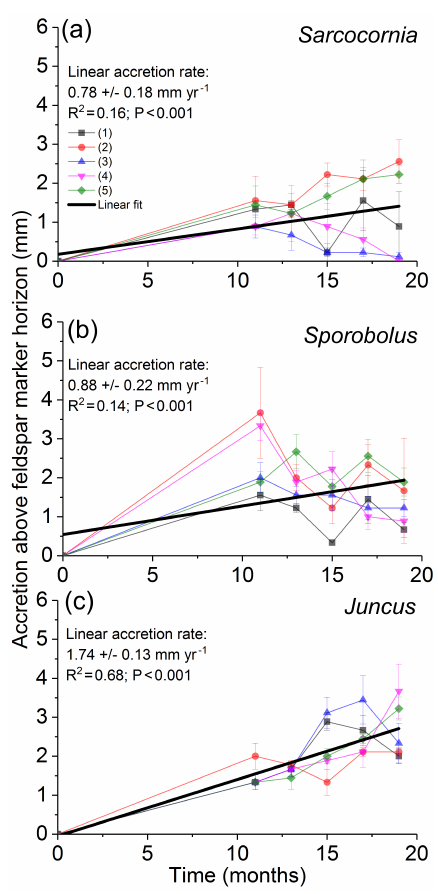
Figure 2. Surface accretion above feldspar marker horizons. Data are presented as the mean ± standard error of three replicate plots at each of five locations for each vegetation assemblage. A linear fit was applied on the basis of all data points ( n = 90) for each vegeta- tion